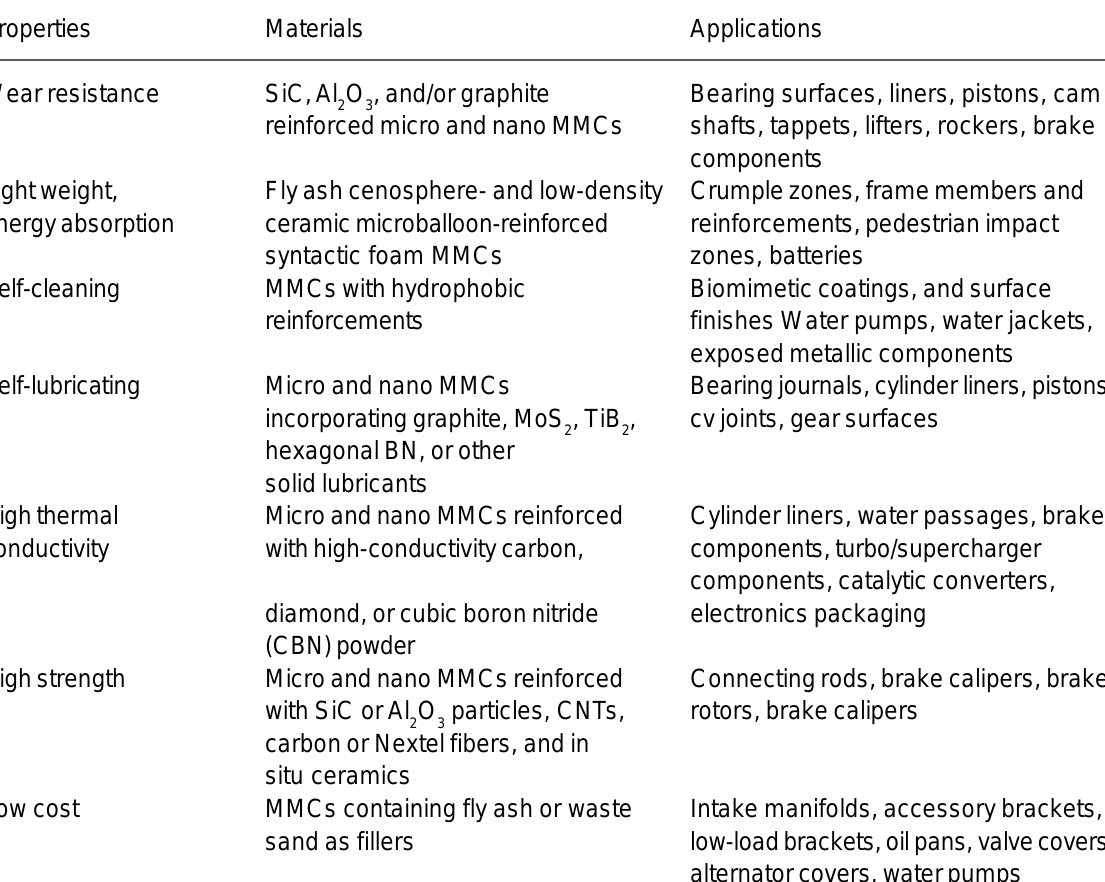
Table1. MMCs being developed for use in automotive applications, adapted from [27].